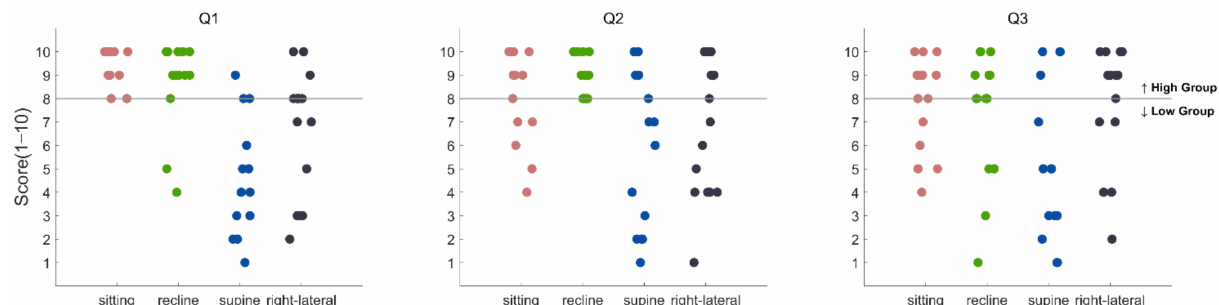
Figure 6. Scores for each question in each posture (sitting, recline, supine, and right lateral recumbent postures). The grey line shows a threshold for dividing the high-scoring group and the low-scoring group. Scores equal to or higher than the threshold were included in the high-scoring